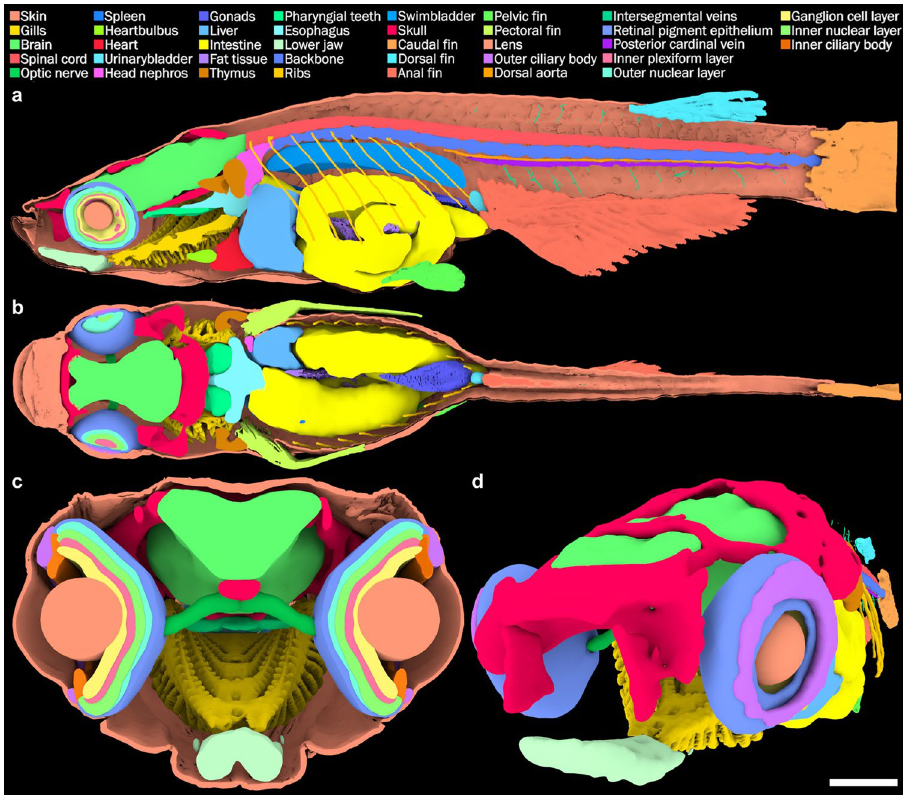
Figure 4. 3D anatomical atlas ( a ) sagittal, ( b ) coronal, ( c ) transverse planes through the 3D interactive model. Each colour represents a unique anatomical organ. Muscles are not shown for better visibility of other organs. ( d ) 3D view of the model (skin is rendered